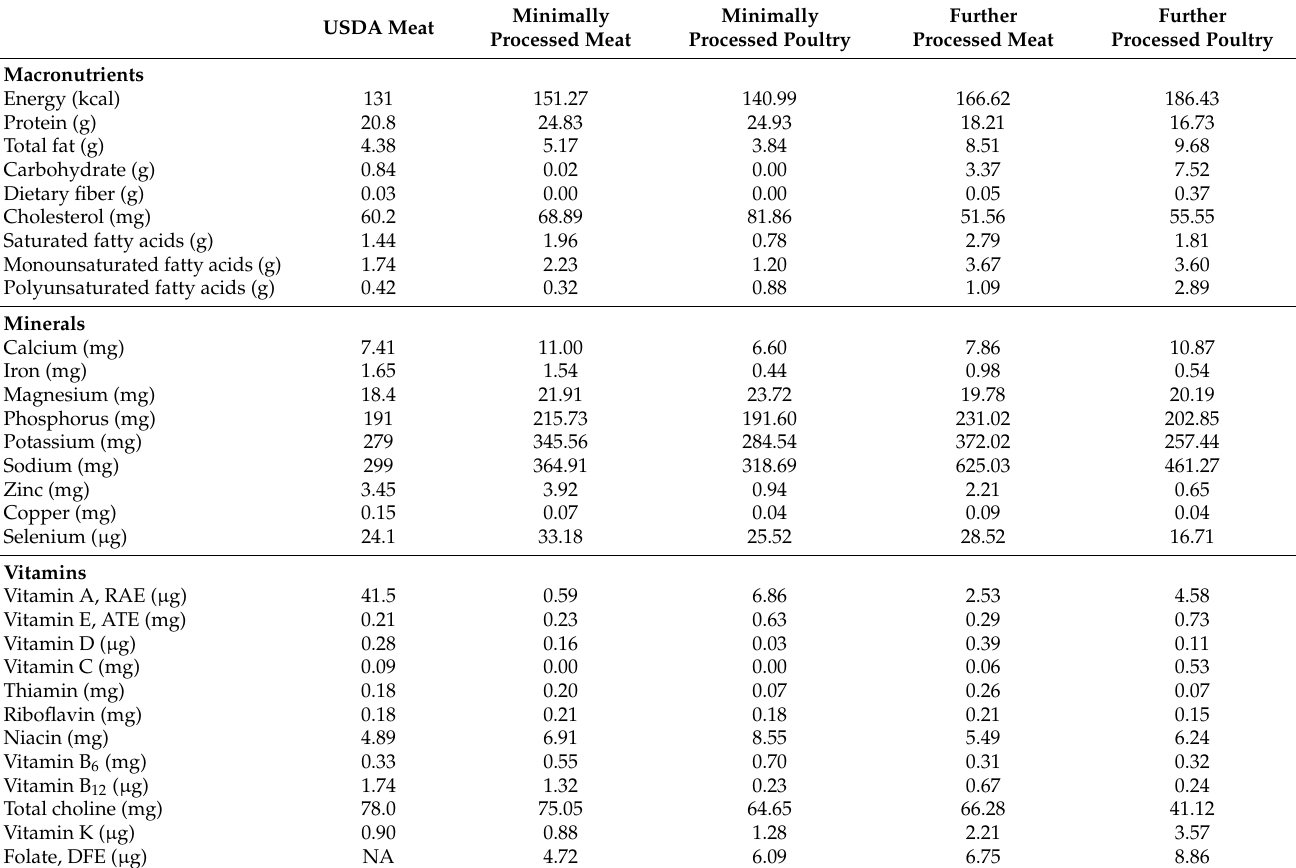
Table 2. Nutrient profiles per 3 oz (85 g) of meat and poultry composites. Minimally Minimally USDA Meat Processed Meat Processed Poultry